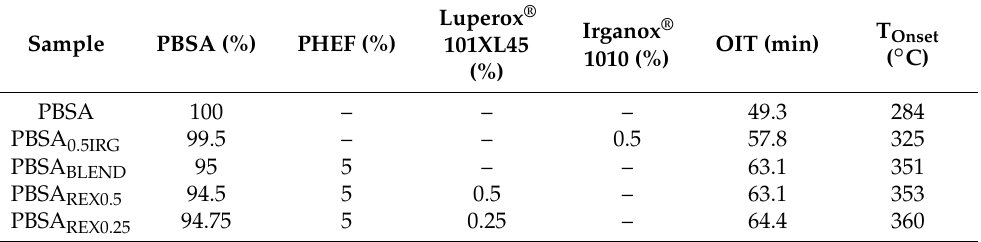
Table 2. Composition of the tested materials and their thermal performances under oxidative